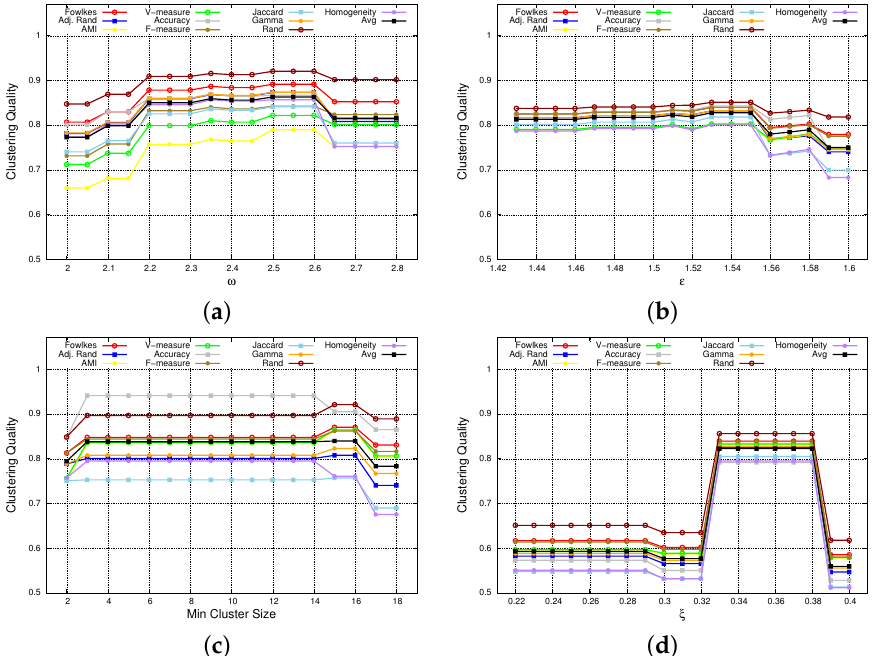
Figure 5. The Compound dataset: clustering quality indices vs. different input parameter values. ( a ) CHD. ( b ) DBSCAN. ( c ) HDBSCAN. ( d )